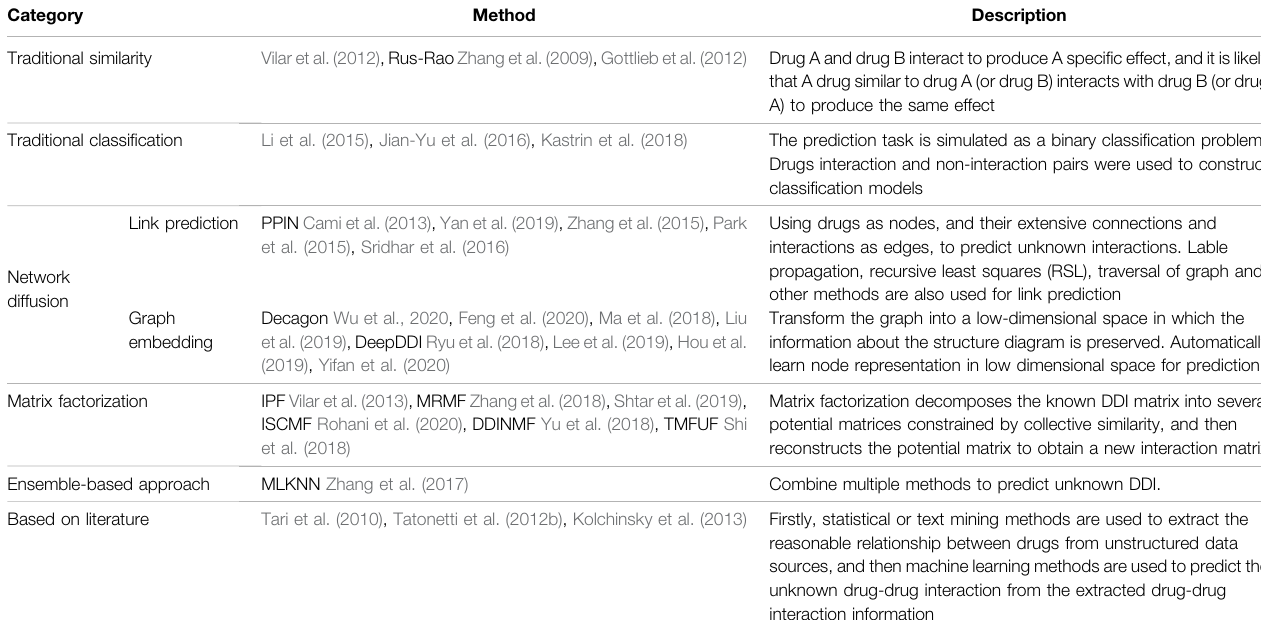
TABLE 1 | DDI prediction methods based on machine